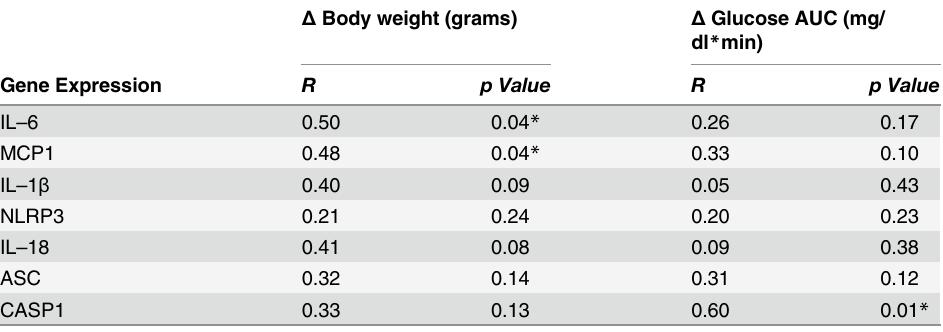
Table 3. Correlation analysis between gene expression, and change in body weight (left) and absolute change in insulin resistance (right) in mesenteric adipose tissue.